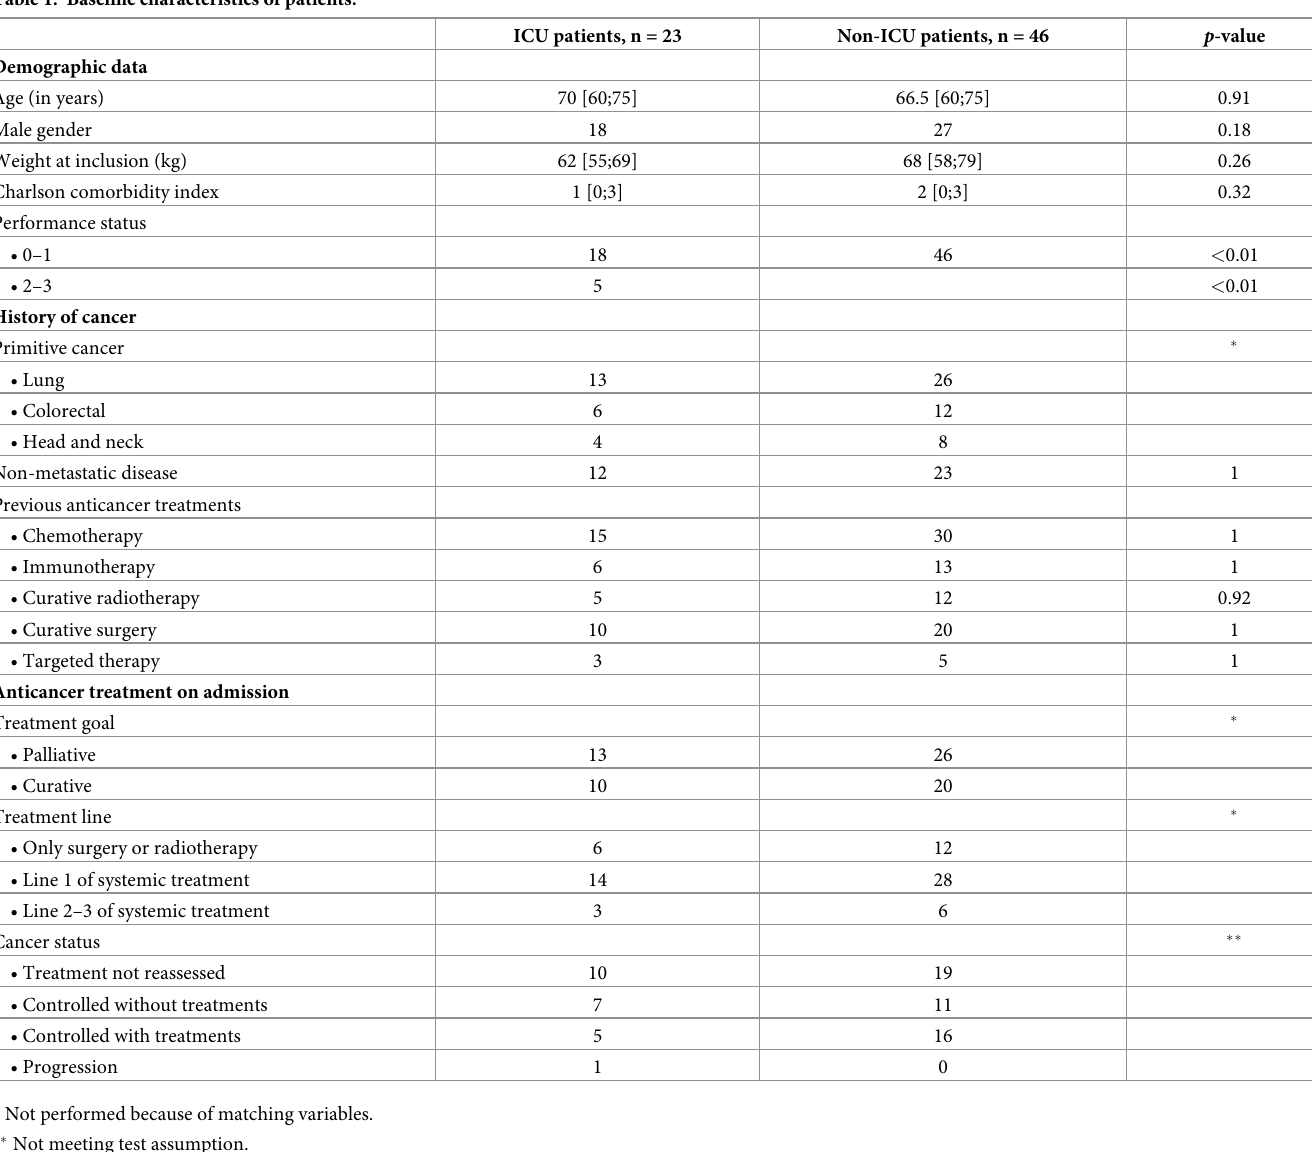
Table 1. Baseline characteristics of